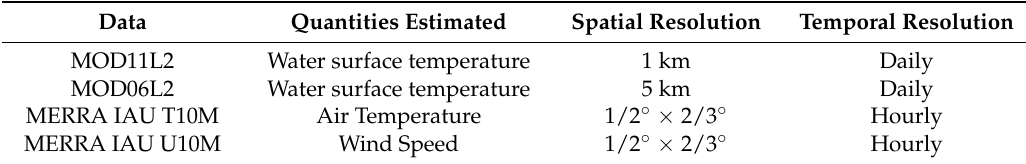
Table 1. Summarized all the data used in this